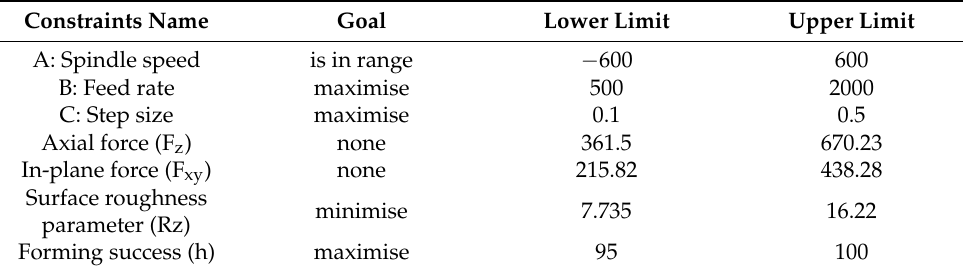
Table 8. Limits used and goals for